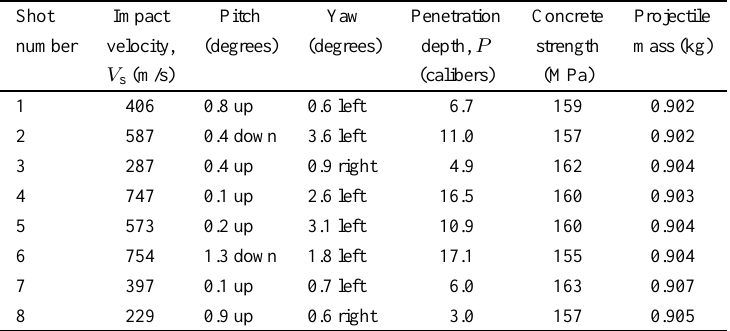
Summary of results from penetration